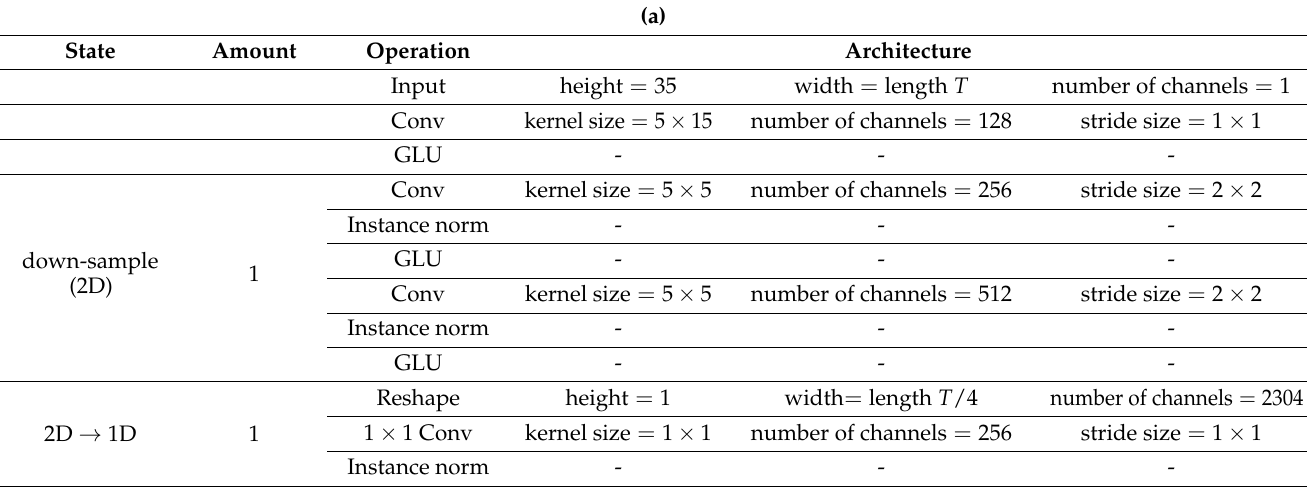
Table 1. ( a ) The generator architecture. ( b ) The discriminator